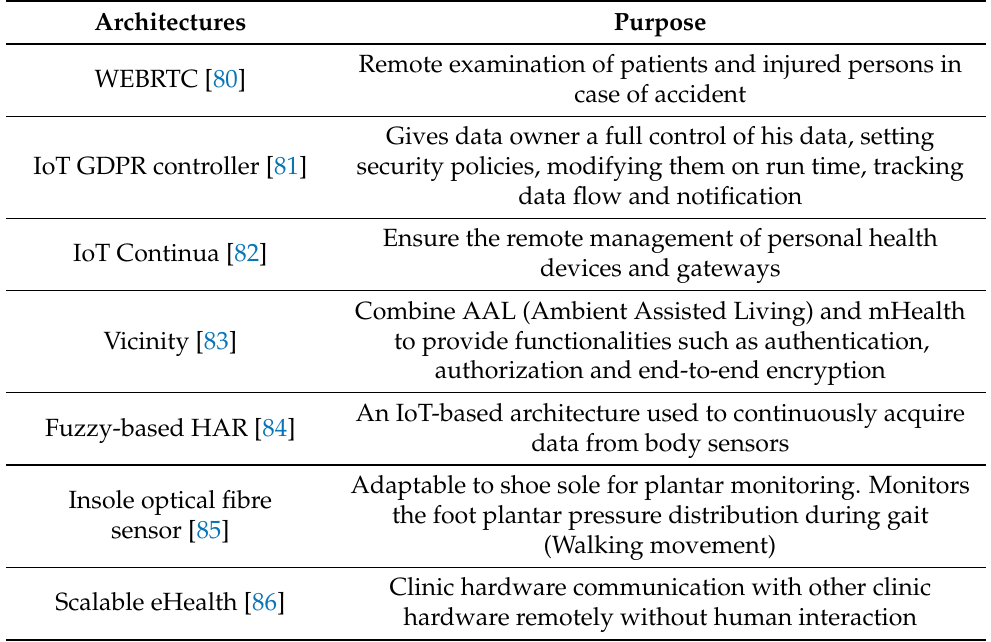
Table 3. Other types of architectures deployed in eHealth